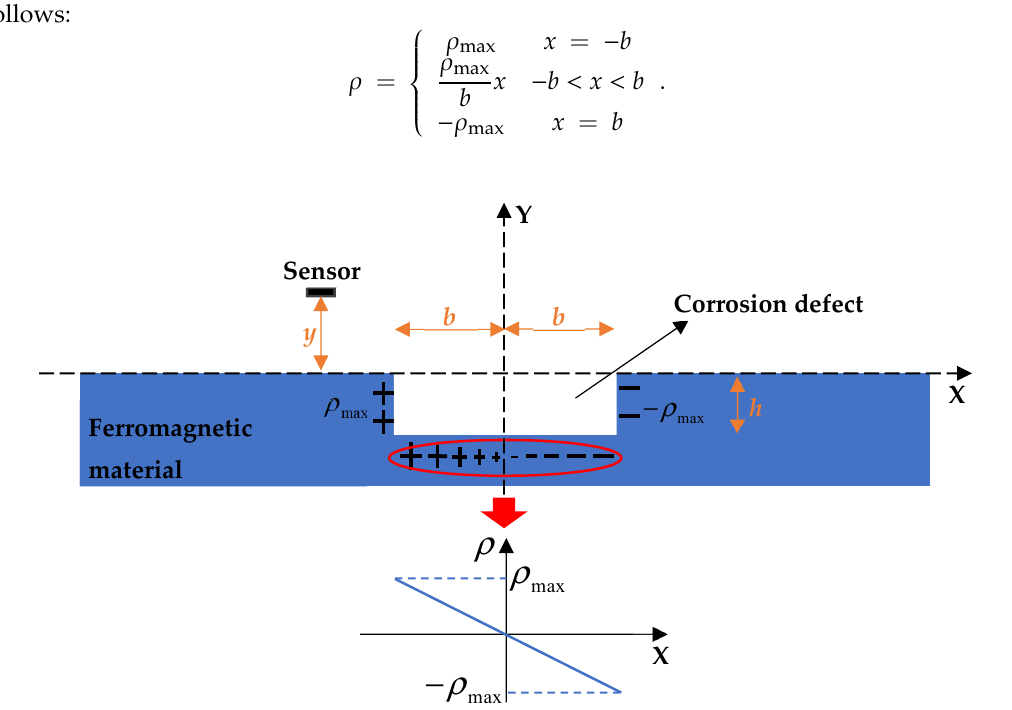
Figure 1. The calculated diagram of magnetic dipole model with the rectangular defect. X : the length direction of ferromagnetic material; b : the half of corrosion width; h : the corrosion depth; ρ max : the magnitude of magnetic charges on both sides of the defect, and the plus and minus symbols represent the plus and minus of magnetic charges; the distribution of magnetic charges at the bottom of the defect is shown in the red circle, which is linearly distributed along the x direction; y : the lift off height.